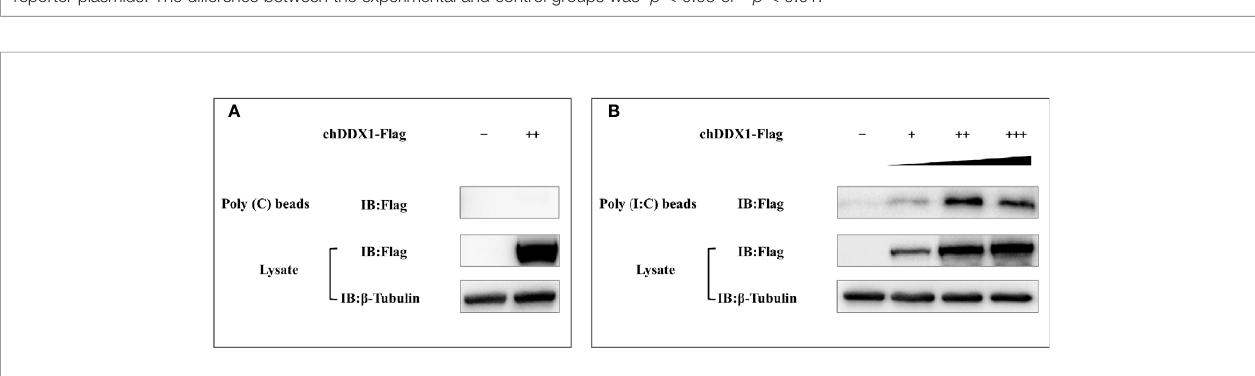
FIGURE 8 | chDDX1 interacted with poly(I:C). (A) Pulldown assay (western blot) for the interaction of chDDX1 and poly(C) in DF-1 cells transfected with the indicated plasmids. (B) Pulldown assay (western blot) for the interaction of chDDX1 and